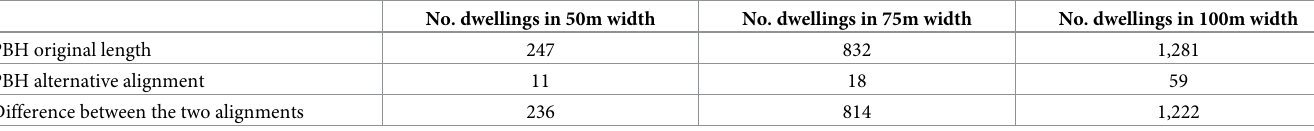
Table 7. Comparison of impacted dwellings of the Pan Borneo Highways original and alternative alignment.